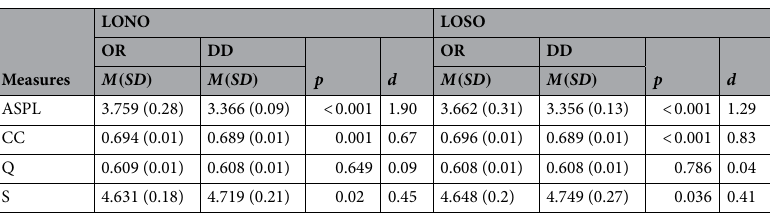
Table 1. Results from the paired two-tailed permutation t-test of the partial networks comparing the OR and the DD conditions. Cohen’s d effect sizes: 0.20, small; 0.50, moderate; 0.80, large; 1.10, very large. LONO leave- one-node-out, LOSO leave-one-subject-out, ASPL average shortest path length, CC clustering coefficient, Q modularity index, S small worldness.